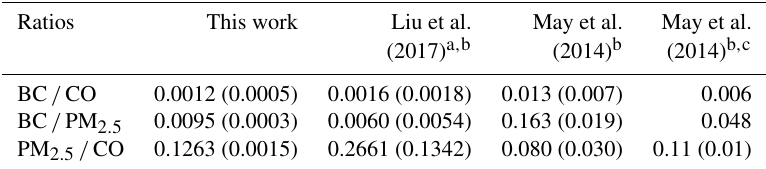
Table 5. Comparison of wildfire emission/enhancement ratios to prescribed fire emission ratios (gg − 1 ). Ratios This